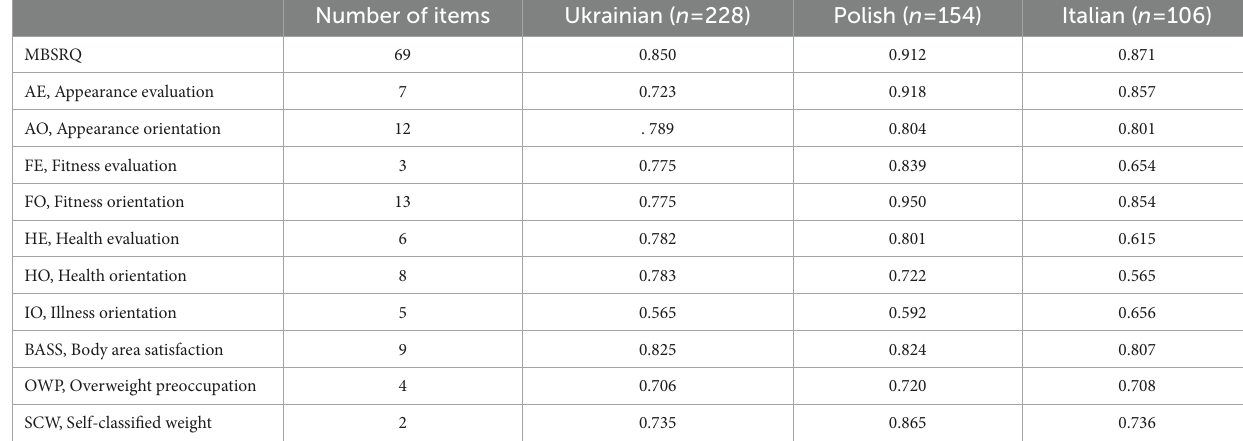
TABLE 3 Reliability analysis (Cronbach’s alpha) of the subscale and the entire MBRSQ in the studied groups of Ukrainian, Polish, and Italian women. Number of